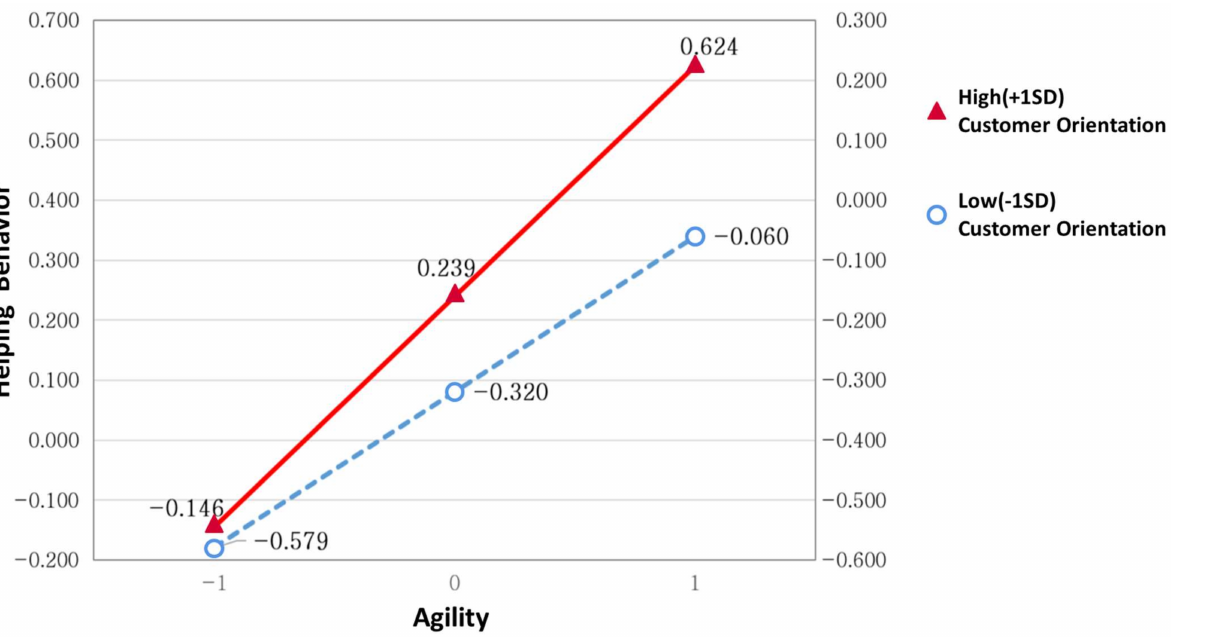
Figure 3. Moderating effect of customer